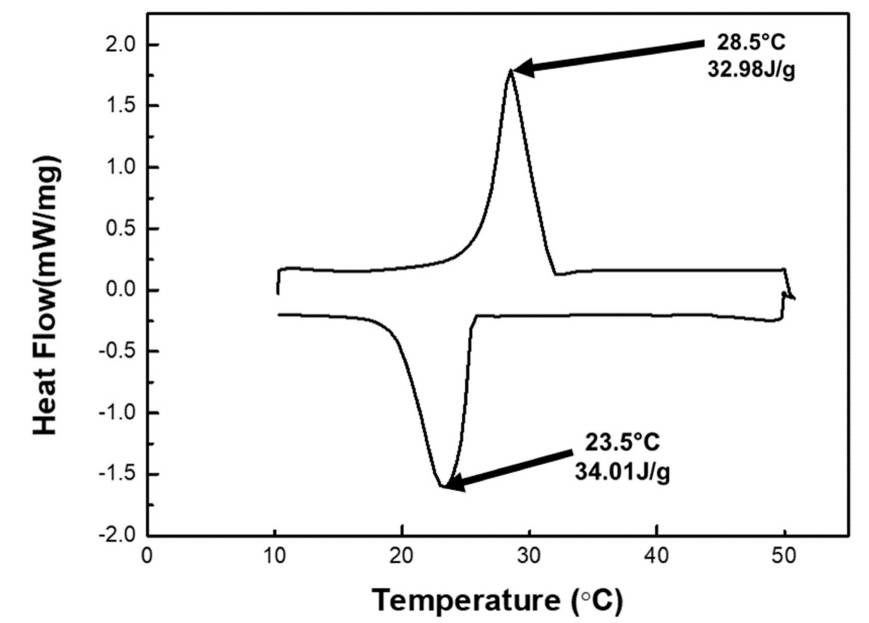
Figure A3. Latent heat of TC5.